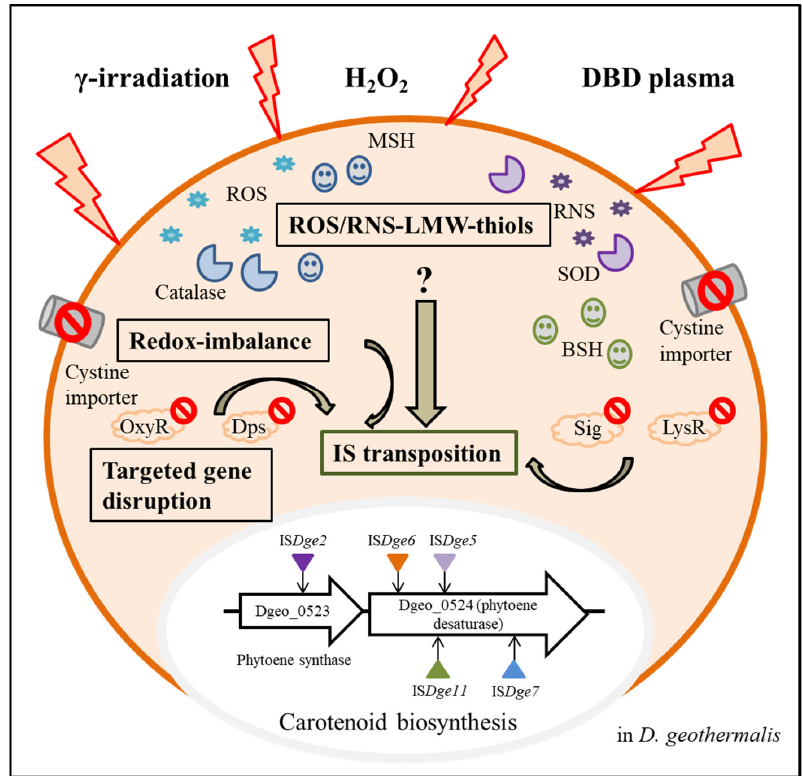
Figure 3. Overview of active transposition of ISs through various intracellular factors in Deinococcus geothermalis from three extracellular stressors. Three extracellular stressors induced ROS and RNS, and a cystine importer ‐ disrupted mutant induced the intracellular redox imbalance state. LMW ‐ thiols, such as bacillithiol and mycothiol, and antioxidant enzymes were produced. As a result of oxidation stress in WT and mutants with targeted gene disruption of oxyR , lysR , dps and sig , particular IS elements were transposed to the carotenoid biosynthesis genes, and phenotypic non ‐ pigment colonies were isolated.